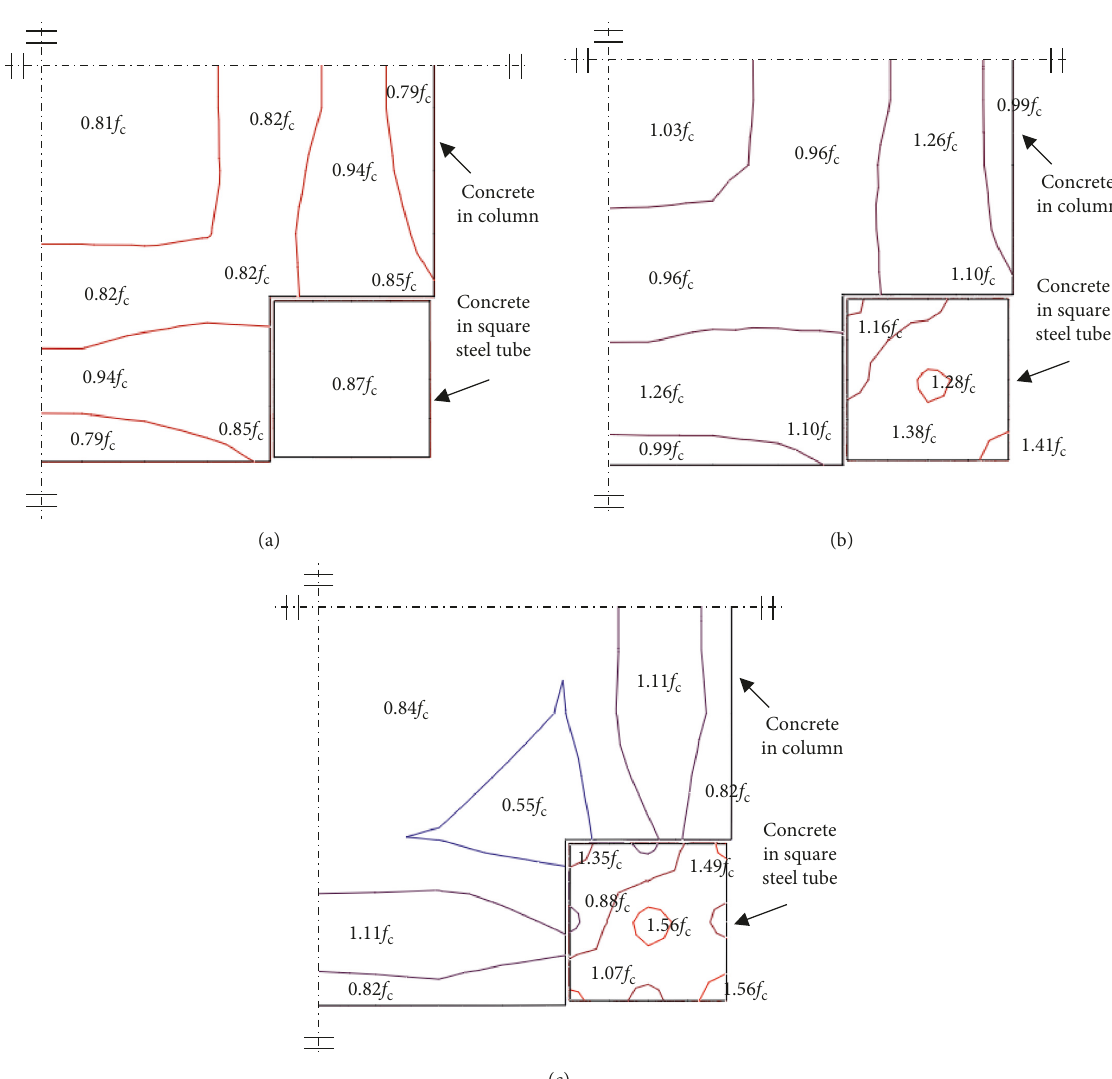
Figure 14: Longitudinal concrete stress distribution in midsections of the ISSCC column. Stress contours under (a) the yield load, (b) the ultimate load, and (c) the ultimate load of